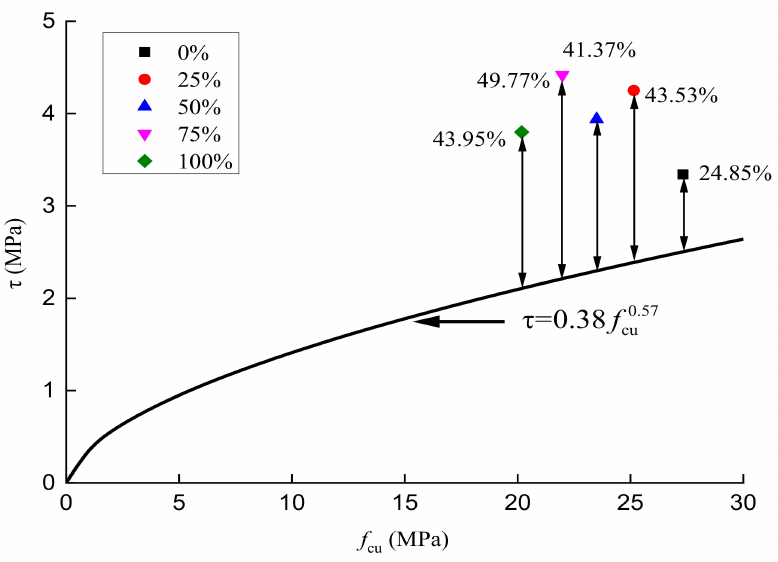
Figure 8. Correlation between the peak compressive stress and peak shear stress of